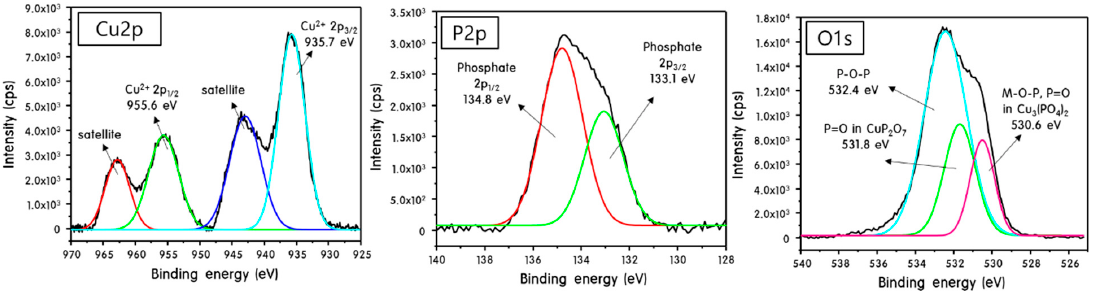
Figure 3. XPS spectra of the Cu 3 (PO 4 ) 2 -Cu 2 P 2 O 7 mpc.